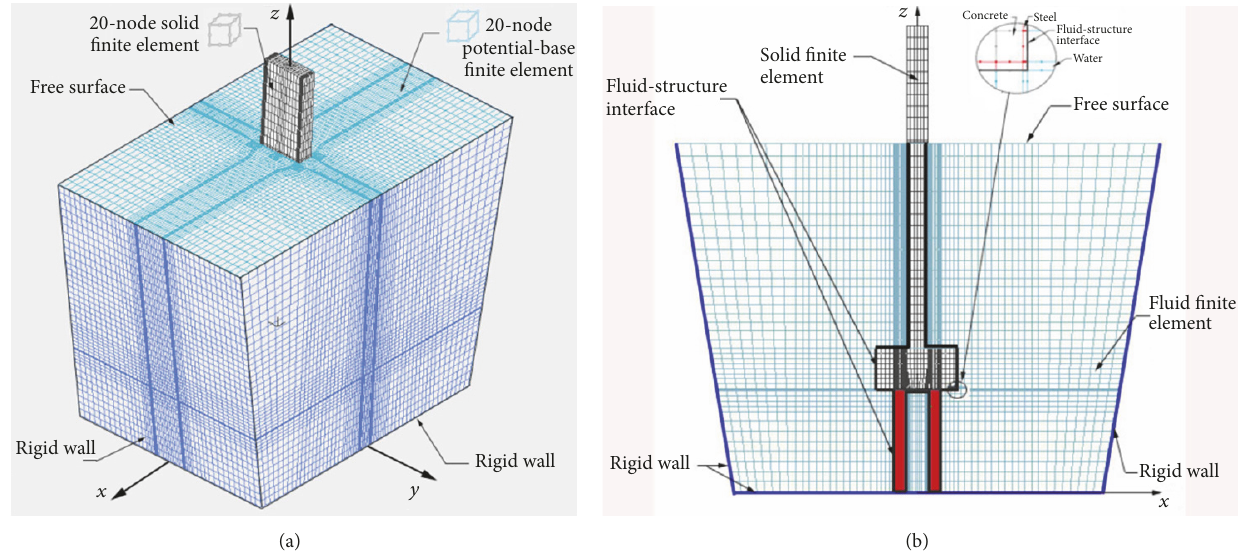
Figure 8: Finite-element model of the pier specimen and surrounding water: (a) overview; (b) elevation view through a central cutting plane.